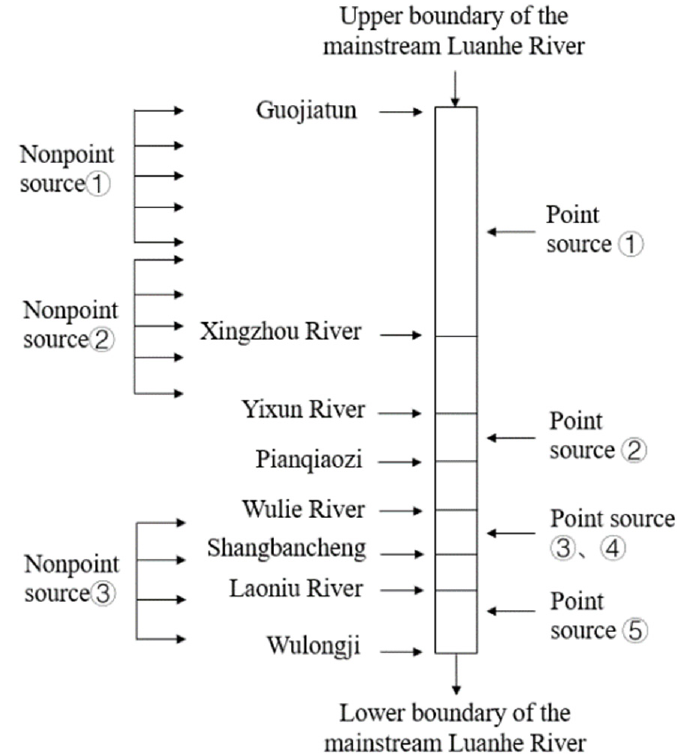
Figure 3. Schematic diagram of pollution source generalization.